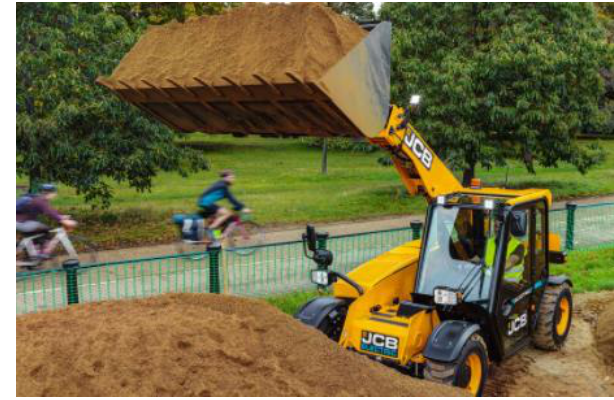
Fig. 32. JCB 525-60e telehandler